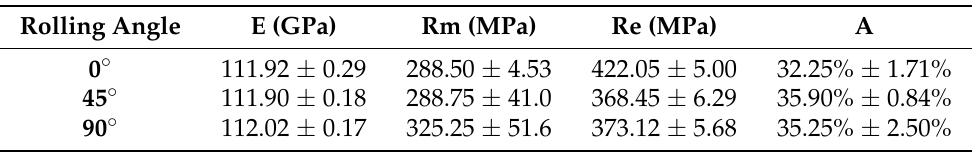
Figure 11. Conventional curve of Grade 2 titanium. Overall, obtained results were consistent according to the Grade 2 α titanium abacus. We could also compare the different standard deviations (cf. Table 3) of each variable for each rolling direction. Table 3 demonstrates the consistency of the experiments. At 90 ◦ , there was a high difference in the value of tensile strength at 45 ◦ linked to the various uncertainties mentioned above. The superposition of flow curves in three directions is depicted in the diagram (cf. Figure 12). Table 3. Mechanical properties of Grade 2 titanium for 3 rolling directions obtained from 4 tensile tests (mean ± standard deviation).